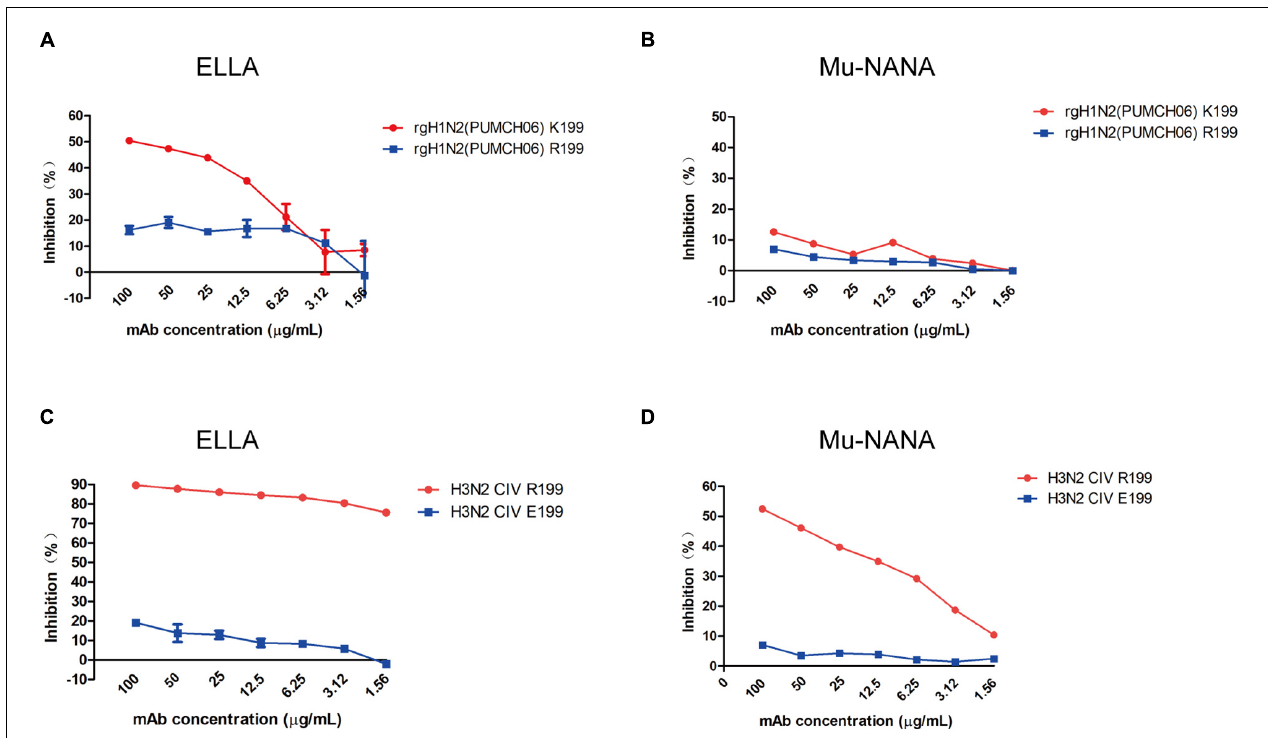
FIGURE 4 | Neuraminidase inhibition ability of mAb 1G8 to mutant viruses. The NI activity of mAb 1G8 to rgH1N2(PUMCH06) viruses with K199 or R199 in NA were measured in both ELLA (A) and Mu-NANA assay (B) . The NI activity of mAb 1G8 to JS06 CIVs with R199 or E199 in NA were measured in both ELLA (C) and Mu-NANA assay (D) . All data of NI assay were performed with Graphpad Prism v.5 and represented as mean ±